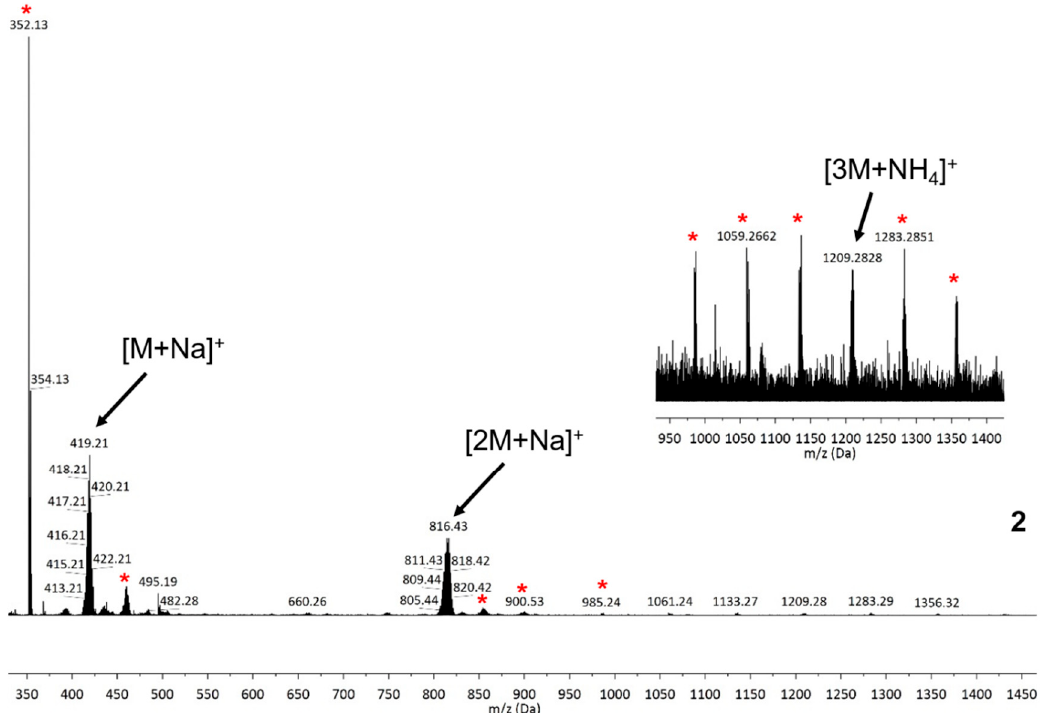
Figure 6. ESI(+) mass spectrum of 2 (M = 397.22), measured in MeCN/H 2 O (98:2, v / v ). The peaks which could not be unequivocally assigned are indicated by *. The inset shows a section of the region m / z = 950 to 1400.